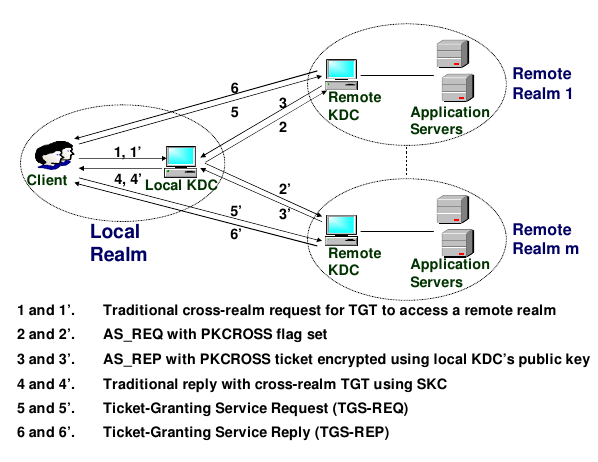
Figure 1. The PKCROSS Message